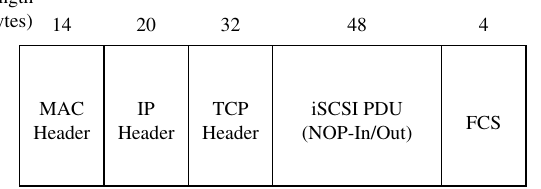
Fig. 2. An Ethernet frame structure of iSCSI